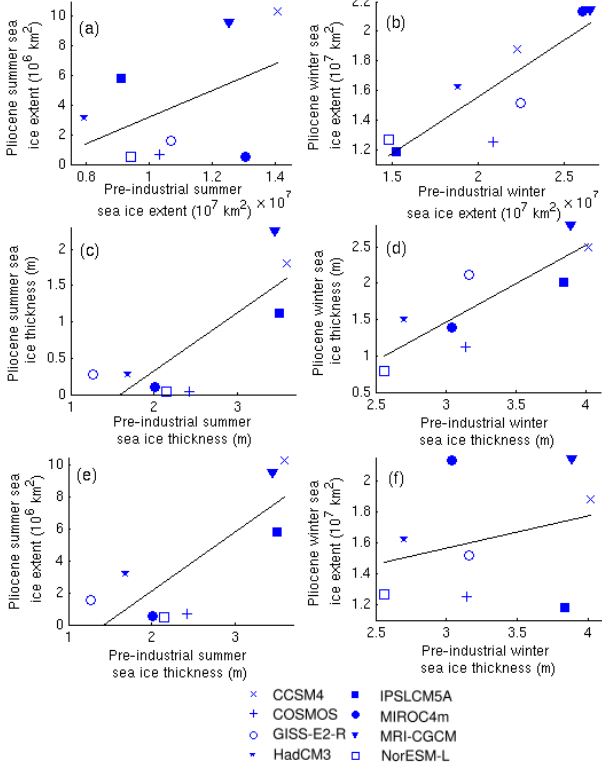
Figure 9. Relationship between various sea ice characteristics. Shown are pre-industrial values vs. mid-Pliocene values for (a, b) sea ice extent vs. sea ice extent, (c, d) sea ice thickness vs. sea ice thickness, and (e, f) sea ice thickness vs. sea ice extent. Panels (a) , (c) , and (e) illustrate summer conditions, while panels (b) , (d) , and (f) illustrate winter conditions. Correlation coefficients for each plot are (a) 0.47, (b) 0.87, (c) 0.82, (d) 0.85, (e) 0.81, and (f) 0.30. Only correlations greater than 0.70 are significant at the 95%